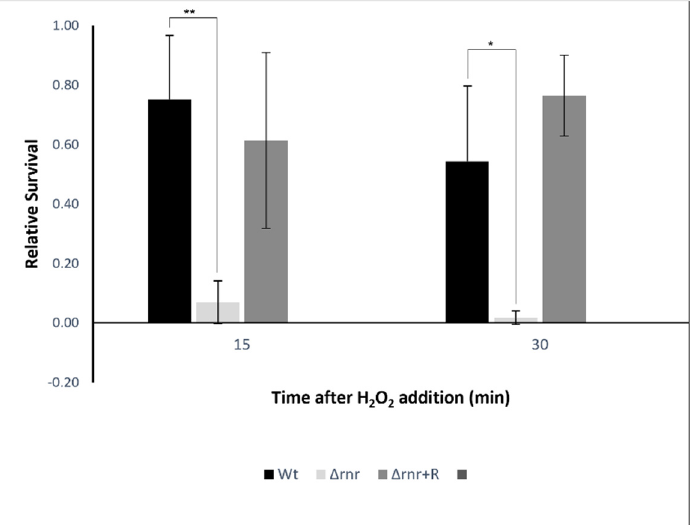
Figure 5. Hydrogen peroxide susceptibility of S. pneumoniae wild type and ∆ rnr mutant derivatives. Exponential cultures were challenged for 15 min and 30 min with 5 mM H 2 O 2 . Viable cells were extrapolated by plating the appropriate dilutions on Todd Hewit medium supplemented with 0.5% Yeast extract (THY) agar plates supplemented with 5% sheep blood. The results were normalized and are presented relative to the number of viable cells obtained for the same culture before stress induction. The results represent an average of at least three independent experiments (* p < 0.05; ** p < 0.01).